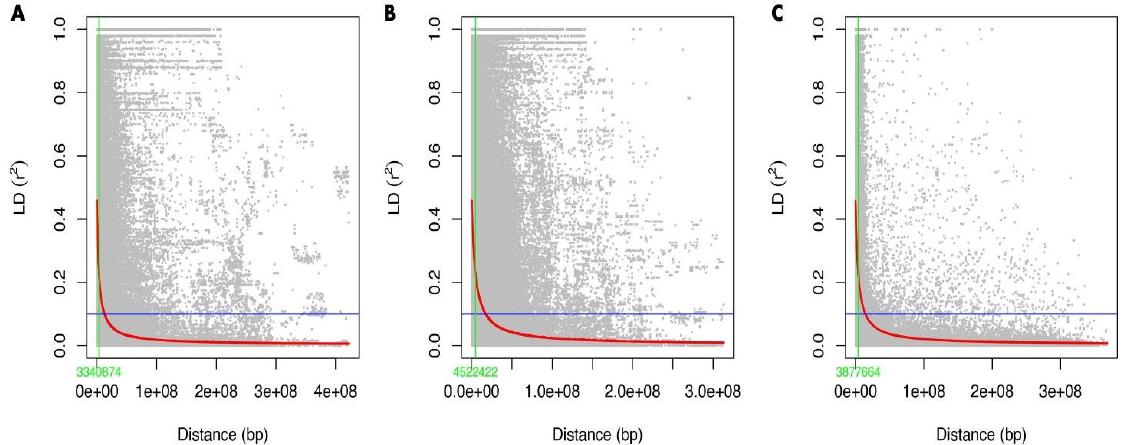
Figure 5. Linkage disequilibrium decay for A genome ( A ), B genome ( B ), and D genome ( C ) of 200 bread wheat genotypes.